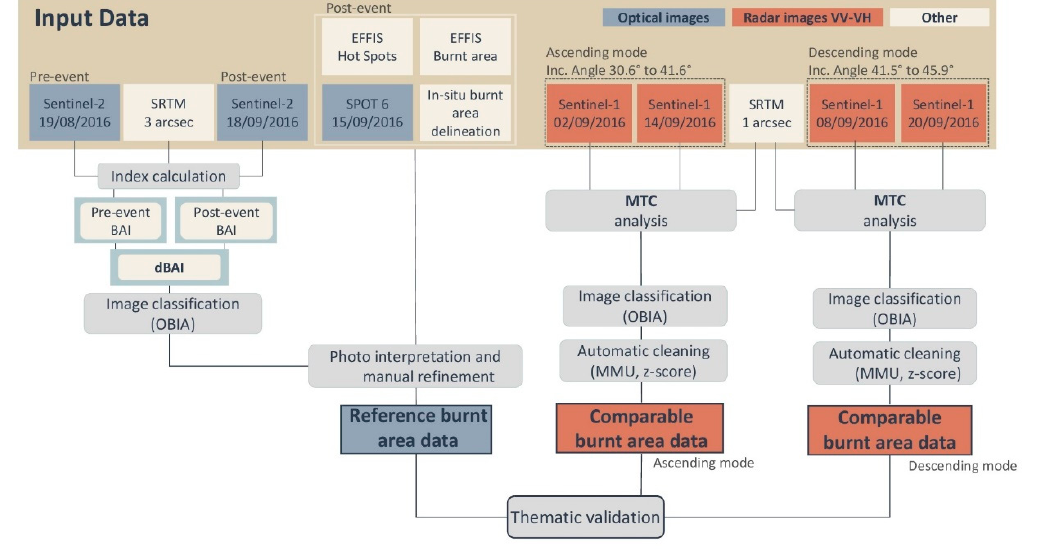
Figure 4. The workflow of the study.